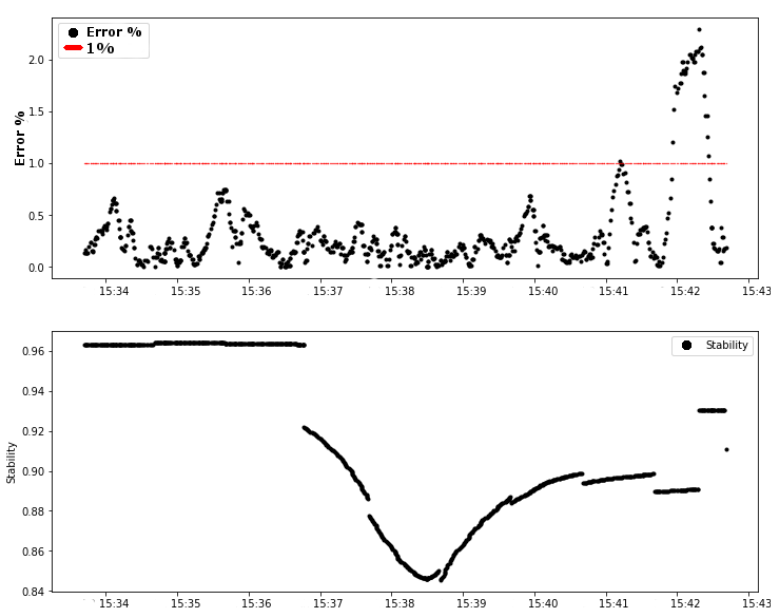
Figure 13. Test 03: error (%) and Link0 stability.